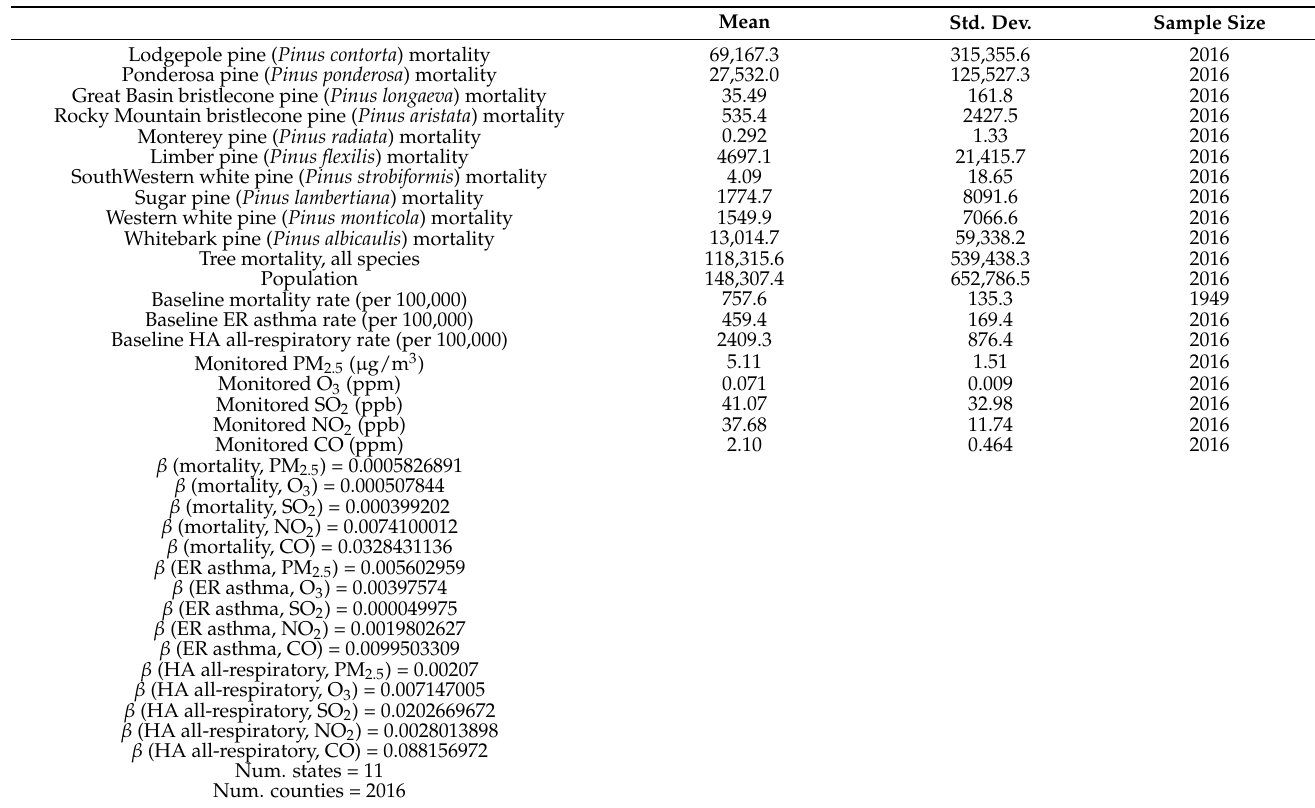
Table 1. Summary statistics and parameter values of model inputs (annual county-level averages).